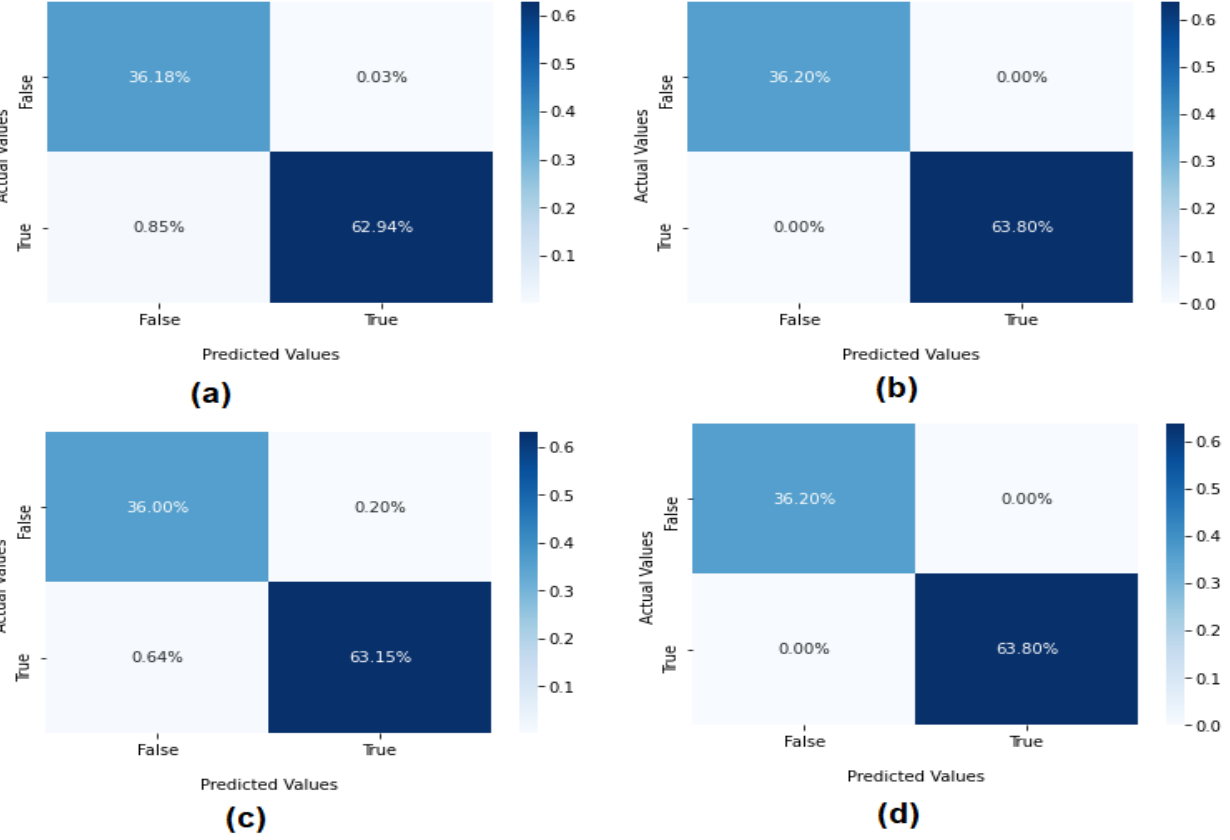
Figure 7. Confusion metrics of ML models: ( a ) logistic regression, ( b ) KNN, ( c ) LDA, and ( d ) DT.